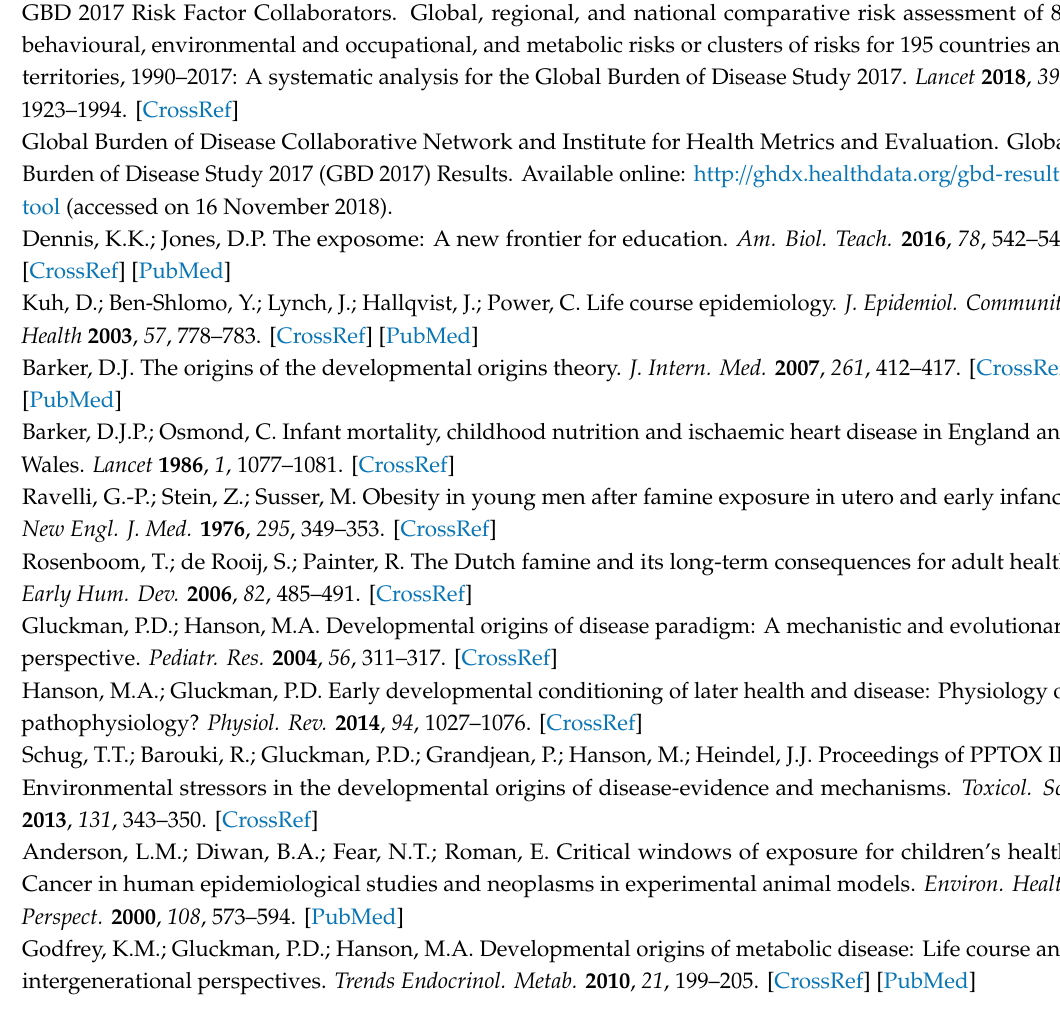
Table S1. Characteristics of meta-analyses included in this work; Table S2. Endpoints and associated population attributable fractions included in this work. Literature search: Details of the systematic literature search (database, date, query). References from the literature review included in BoD estimation Reference list as result of